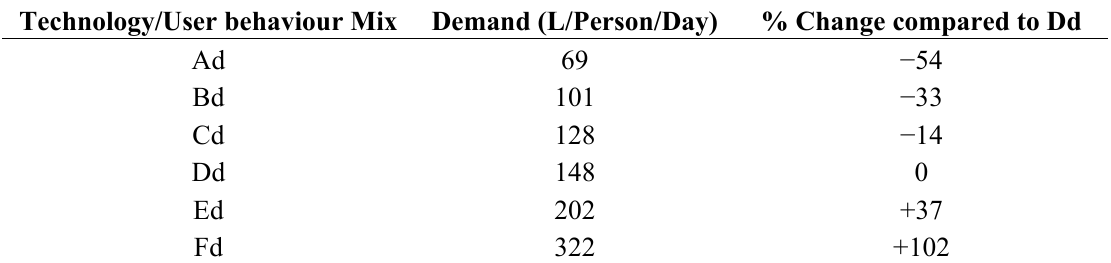
Table 6. Domestic demands achieved through changes in user behaviour alone: “Technological efficiency” unchanged.